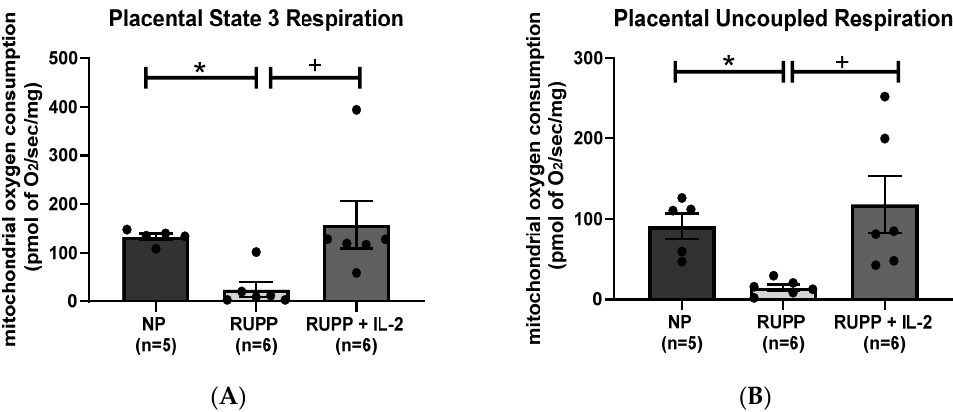
Figure 3. There reductions in ( A ) state 3 and ( B ) uncoupled placental mitochondrial respiration in RUPP rats ( n = 6) compared to RUPP + LD IL-2 ( n = 6) and NP rats ( n = 5). Results were reported as means ± SEM and considered statistically significant when p < 0.05. (* p < 0.05 vs. NP control; + p < 0.05 vs. RUPP).